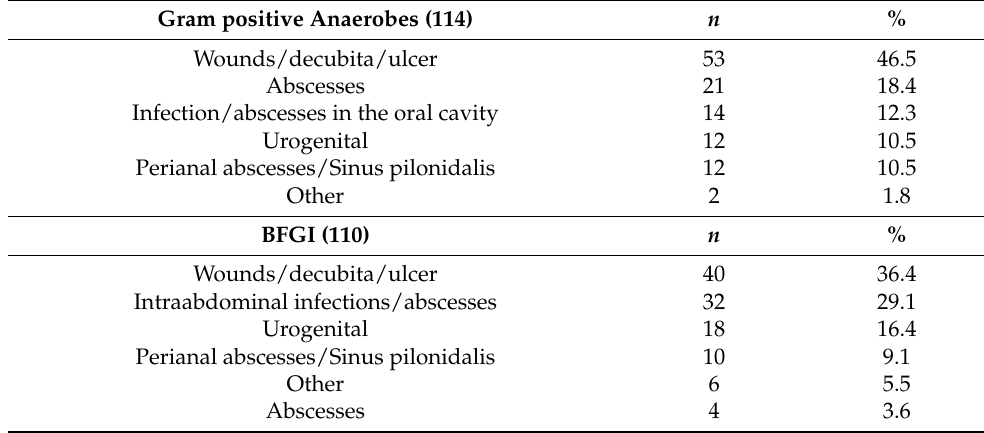
Table 4. Sources of the